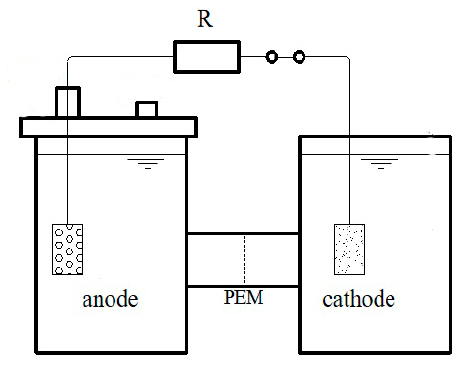
Figure 1. Schematic diagram of the MFC reactor used during the experiment.